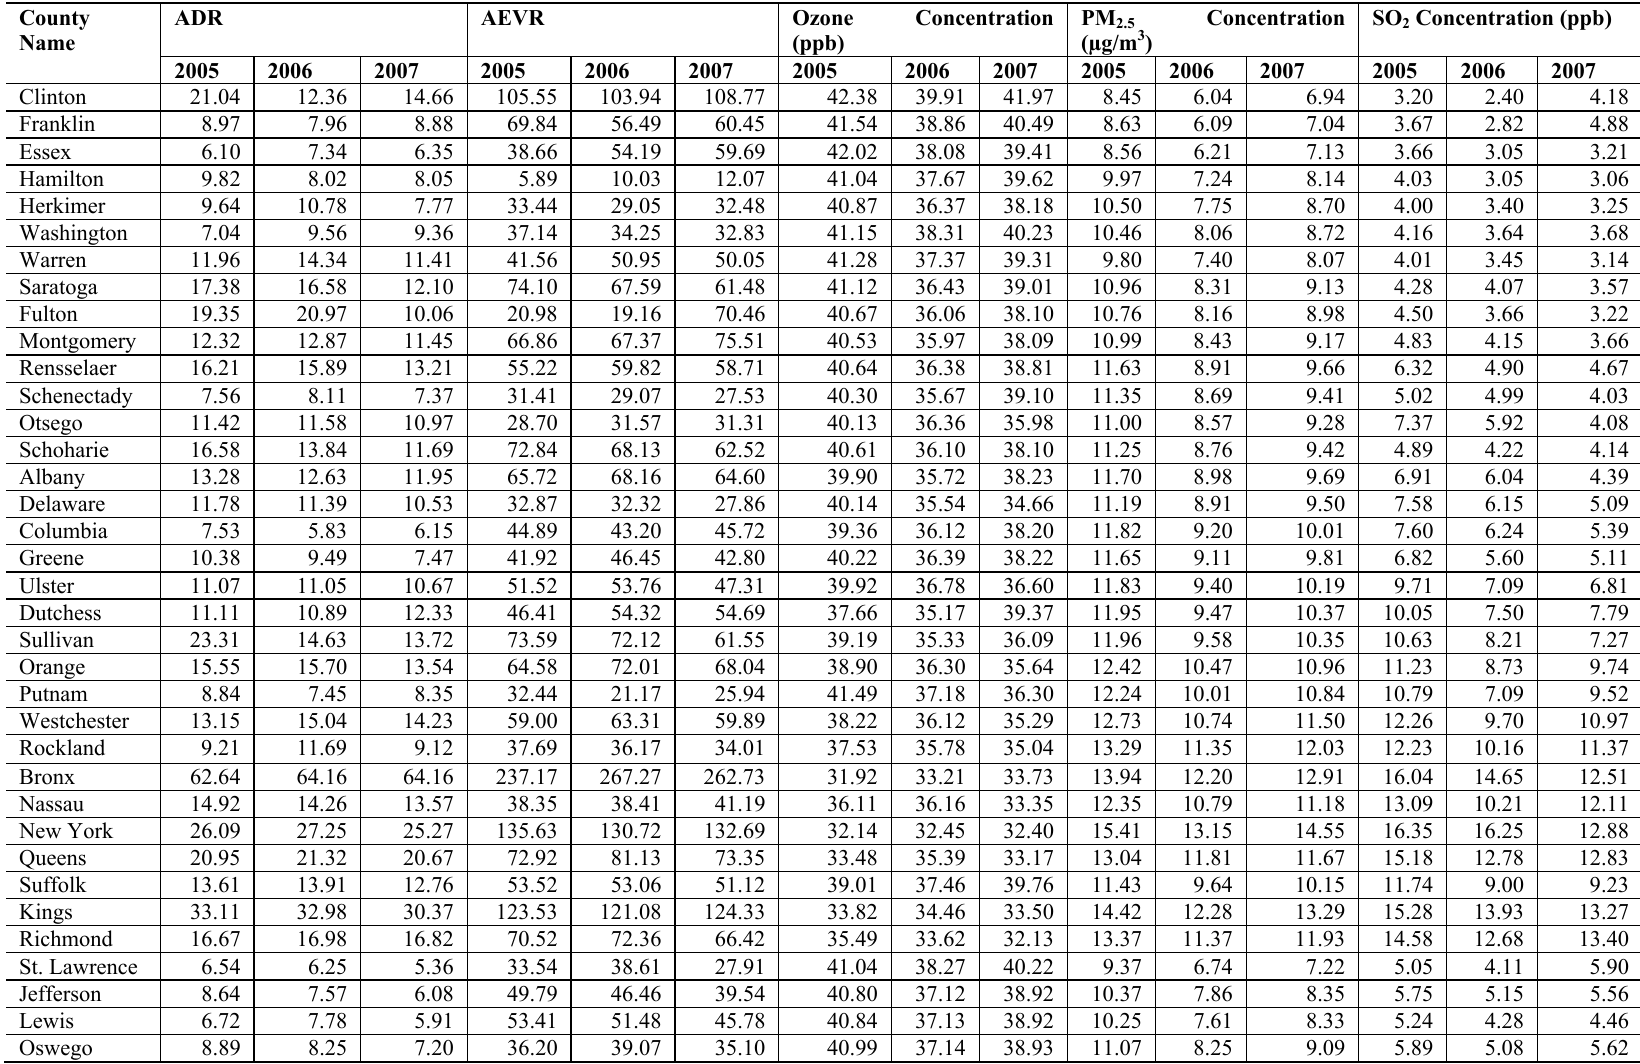
Table 4. Asthma rate at the centroid of each county along with extracted pollutant concentration from interpolated maps.